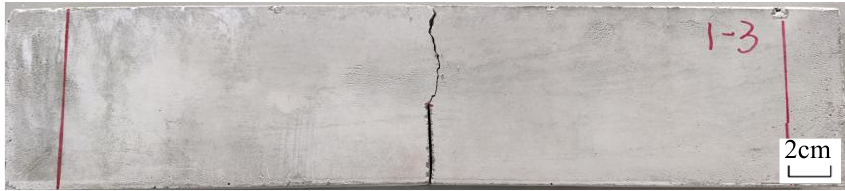
Figure 13. Failure mode of the three-point bending test specimen. Table 4. Fracture energy of the ECC matrix with different sand